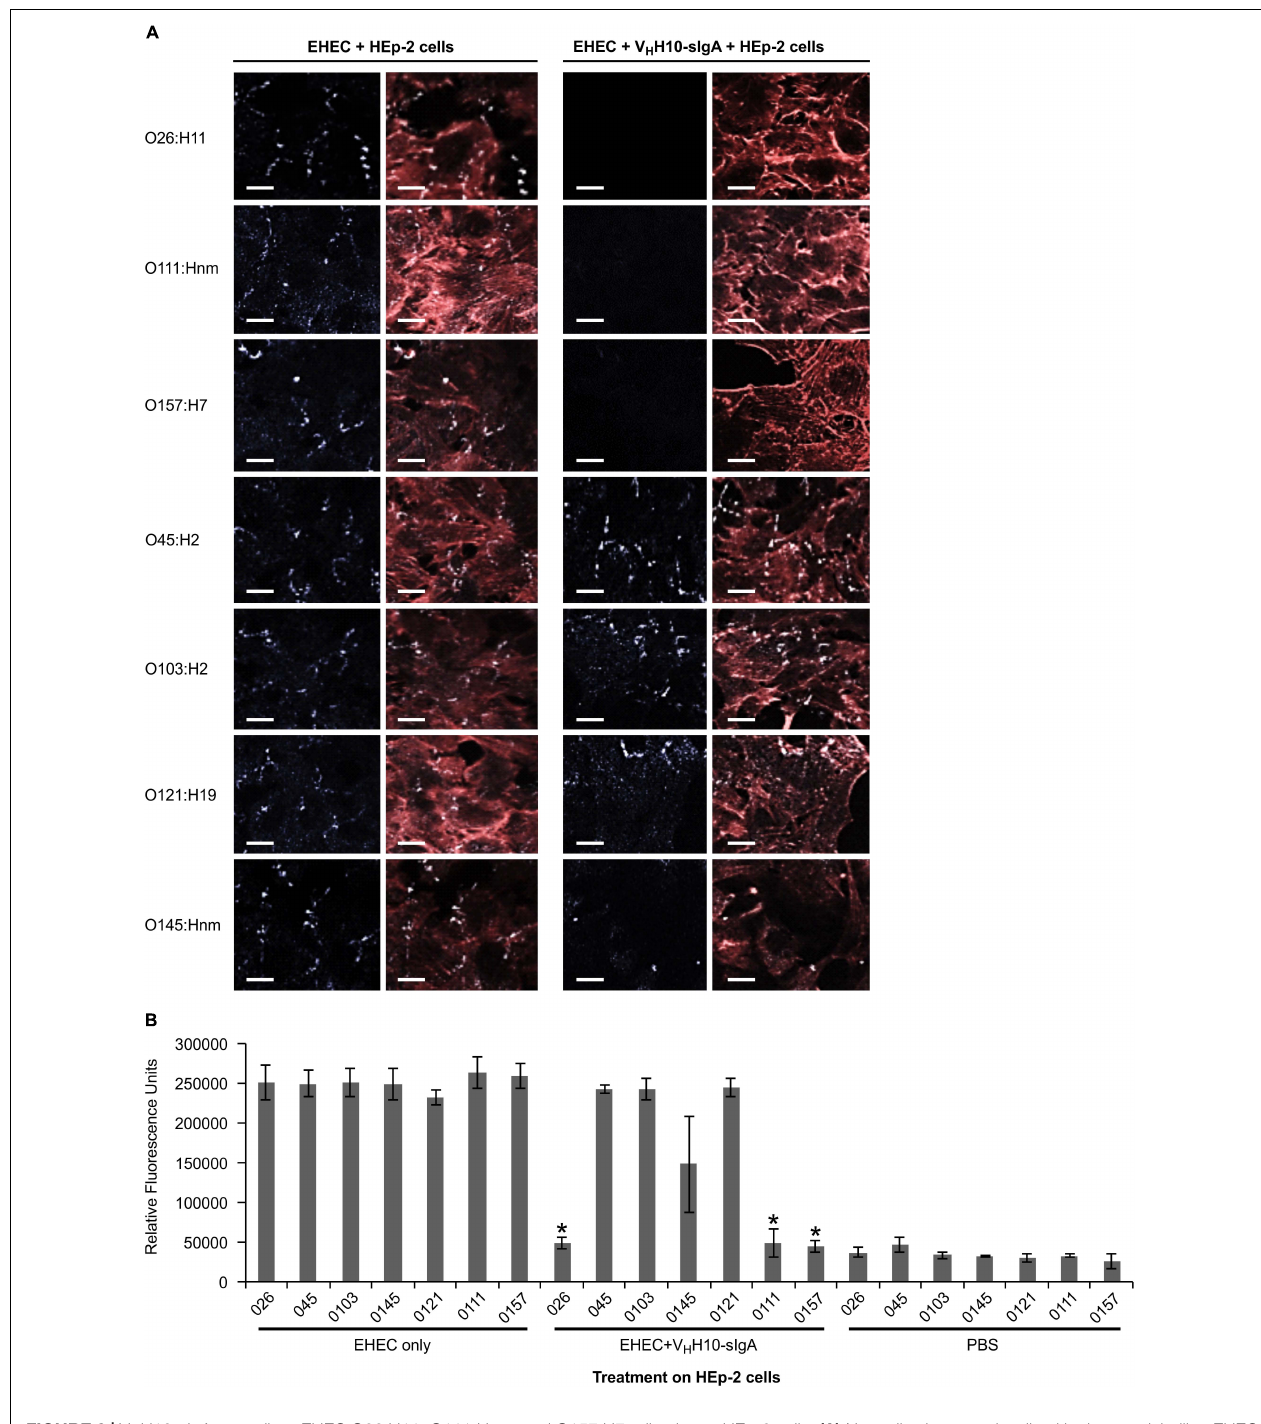
FIGURE 9 | V H H10-sIgA neutralizes EHEC O26:H11, O111:Hnm, and O157:H7 adhesion to HEp-2 cells. (A) Neutralization was visualized by immunolabelling EHEC cells with a donkey anti-rabbit secondary antibody (white) as well as the actin cytoskeleton of HEp-2 cells using rhodamine phalloidin (red). Shown are merged images of the red and white channels for either HEp-2 cells incubated with EHEC alone (left panel) or with EHEC and V H H10-sIgA (right panel). (B) V H H10-sIgA reduces fluorescence of O26:H11, O111:Hnm, and O157:H7 to background levels. Shown is the relative fluorescence of EHEC strains that have been immunolabeled, are adherent on HEp-2 cells, and either incubated on HEp-2 cells alone or in combination with V H H10-sIgA. As a negative control, HEp-2 cells were incubated with PBS instead of a bacterial strain or antibody. ∗ indicates a significant reduction of the amount of immunolabeled adherent bacteria as determined by a one-tailed unpaired homoscedastic T -test between an EHEC strain alone versus the same EHEC strain with V H H10-sIgA added ( p < 0.05, N = 3 biological replicates). Error bars indicate standard errors of the means.